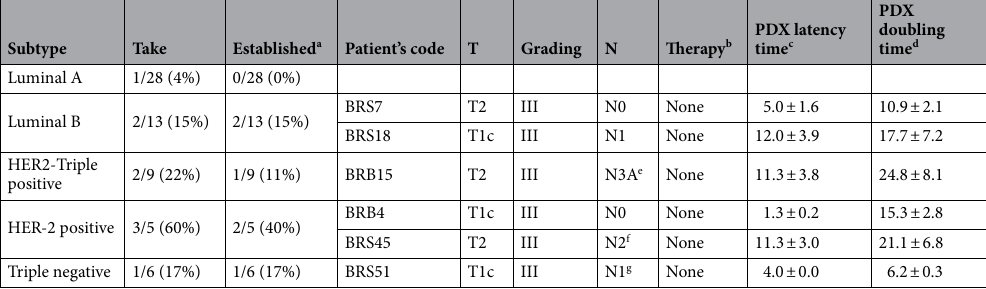
Table 1. PDX from untreated primary human breast cancers of different subtypes. a At least 3 passages. b Therapeutic treatment received by patients before surgical removal of the primary tumor from which the PDX was established. c Mean weeks ± SEM of the 3rd in vivo passage (3–7 independent determinations). d Mean days ± SEM of the 3rd in vivo passage (3–7 independent determinations). e 11/29 positive lymph nodes. f 9/25 positive lymph nodes. g 3/30 positive lymph